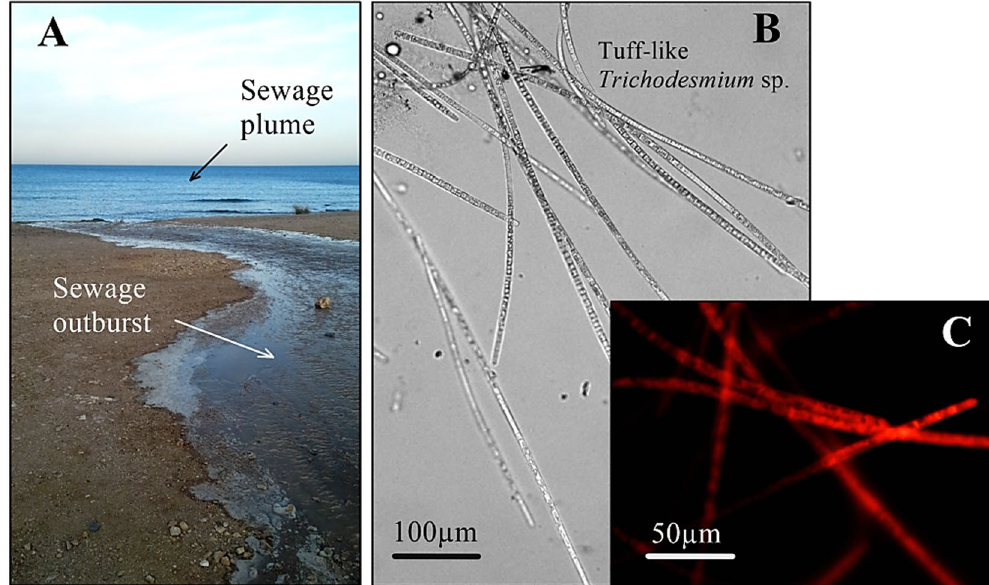
Figure 1. ( A ) Sewage outburst into the coastal SEMS water in February 2015; ( B ) dense Trichodesmium spp. colonies observed under bright field microscopy; ( C ) Trichodesmium spp. autoflorescence following excitation with a phycocyanin filter, in which gas vacuoles are seen as black voids. The picture was taken by E.